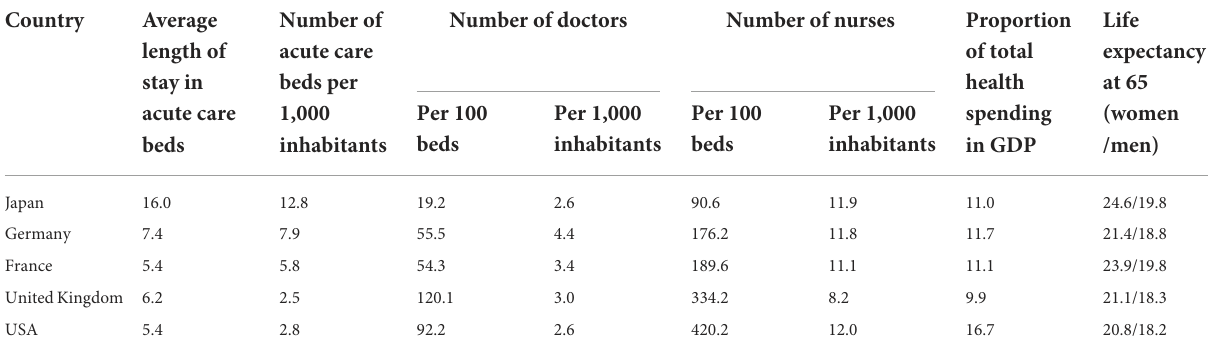
TABLE 5 OECD data (2019).